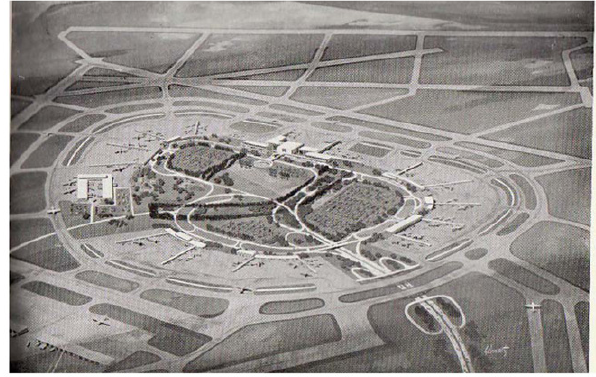
Figure 3. Eugéne Pépin, Géographie de la circulation aérienne , (1956): “Project d’artiste pour la zone central de l’aéroport, (Port of New York Authority)”